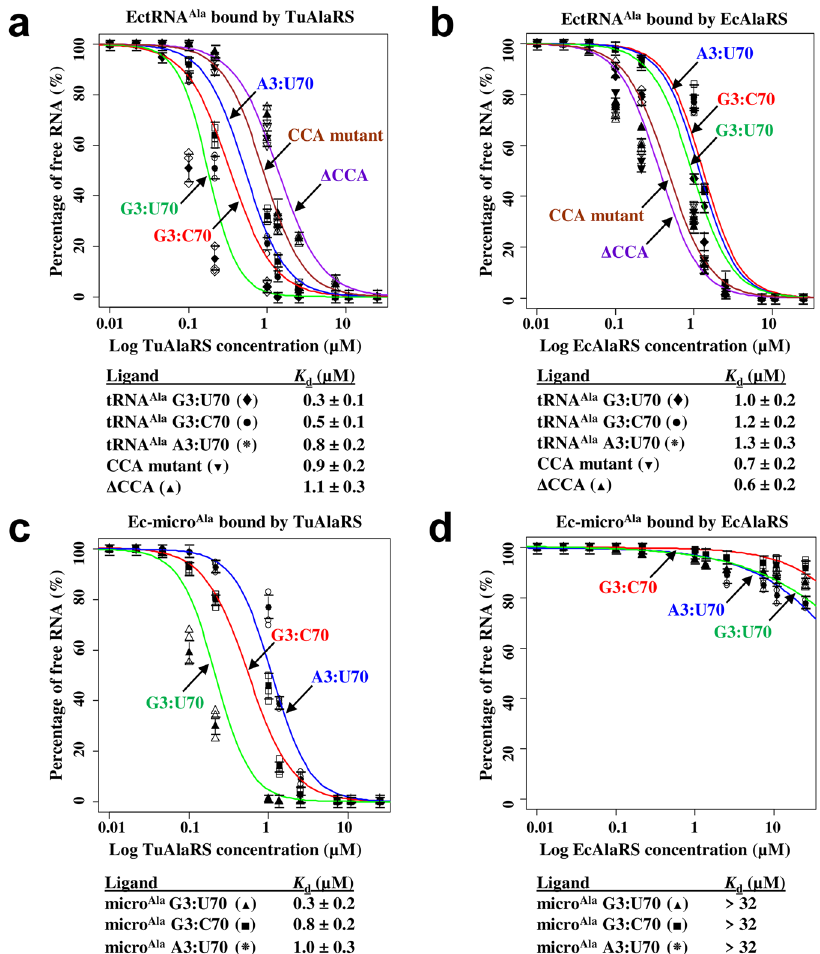
Fig. 3 Binding of TuAlaRS and EcAlaRS to EctRNA Ala and Ec-micro Ala transcripts. The binding af fi nities of ( a ) TuAlaRS and ( b ) EcAlaRS for WT and mutant EctRNA Ala transcripts were determined by an EMSA with protein concentrations ranging from 32 to 0.0625 μ M. The binding af fi nities of ( c ) TuAlaRS and ( d ) EcAlaRS for WT and mutant Ec-micro Ala transcripts were determined under similar conditions. Error bars are standard deviation from triplicates.